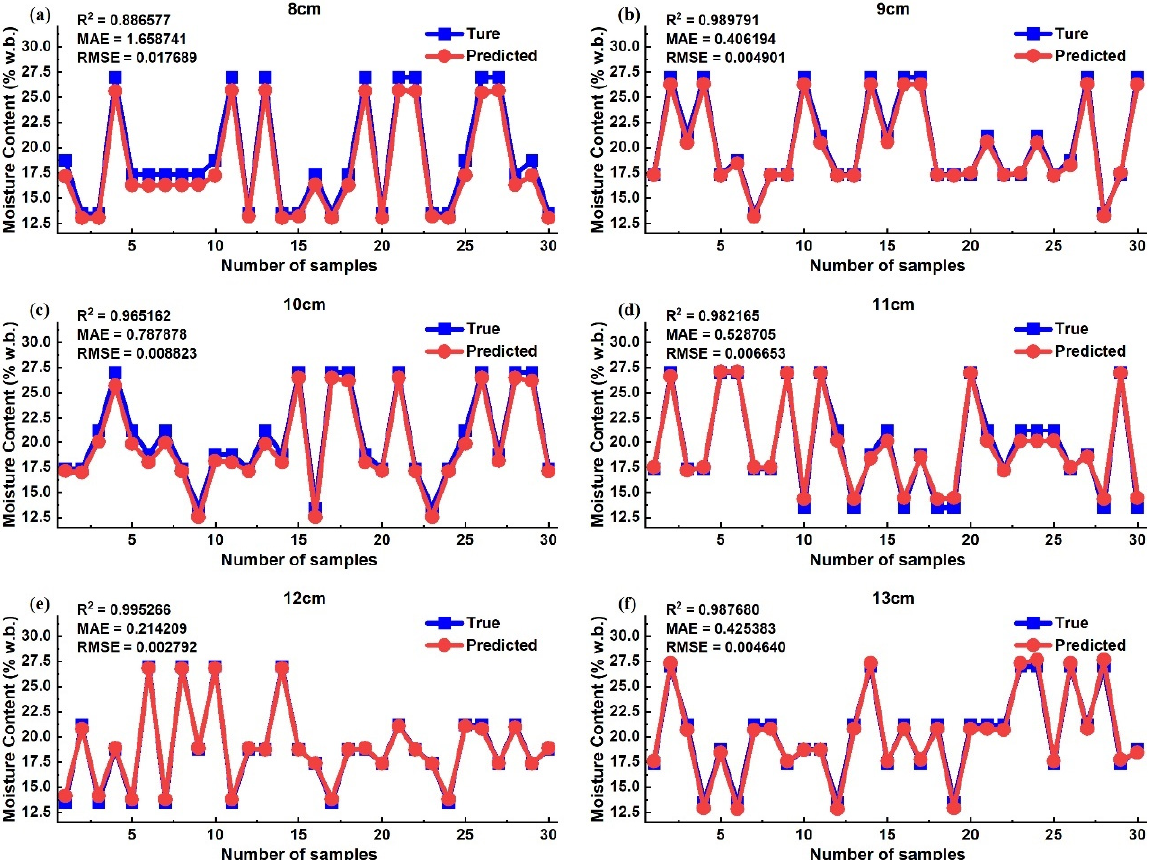
Figure 10. Prediction results under different sample thicknesses: ( a ) with the thickness of 8 cm; ( b ) with the thickness of 9 cm; ( c ) with the thickness of 10 cm; ( d ) with the thickness of 11 cm; ( e ) with the thickness of 12 cm; ( f ) with the thickness of 13 cm.